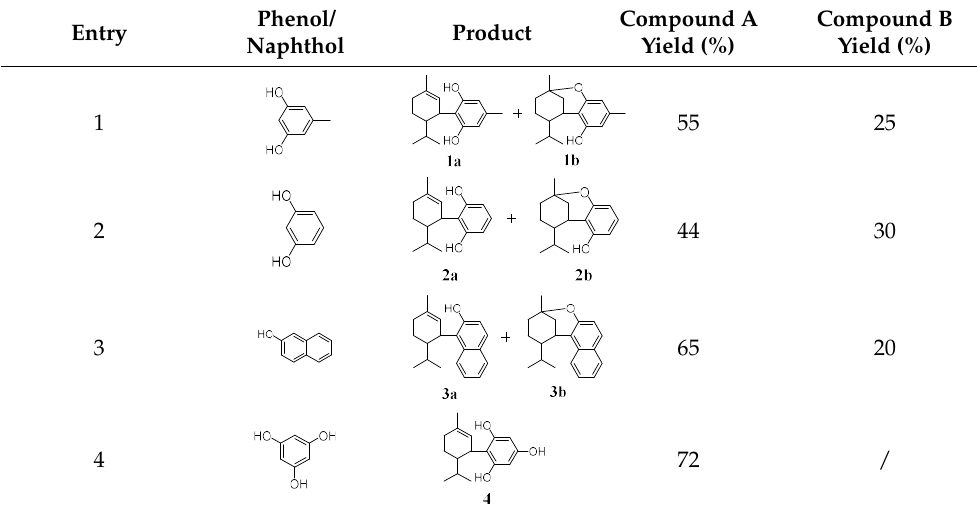
Table 2. Production yields of the synthetic cannabinoid analogues other than H 2 CBD.